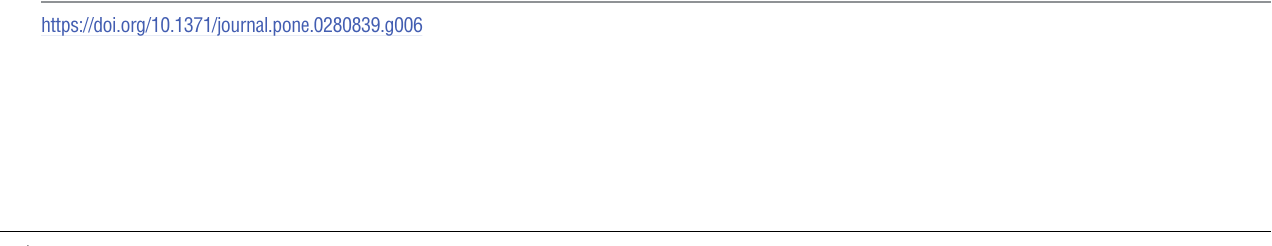
PLOS ONE | https://doi.org/10.1371/journal.pone.0280839 February 15,